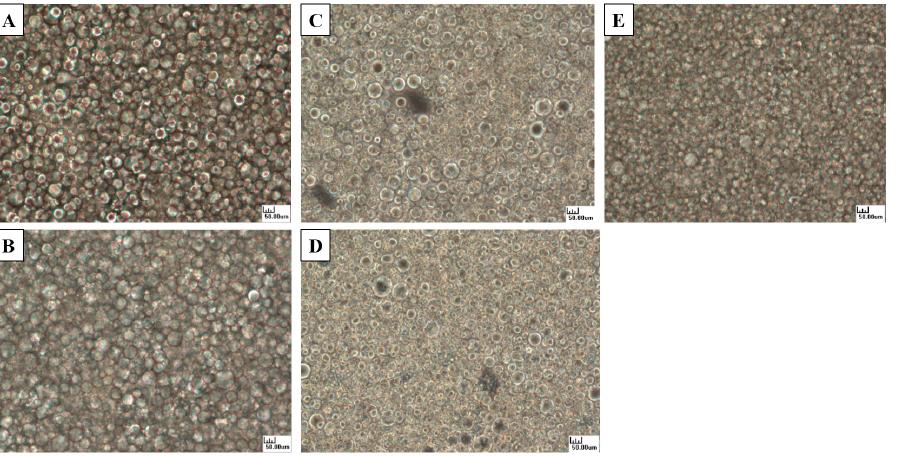
Figure 4. Optical micrographs of the mayonnaise samples. ( A ) Soybean oil; ( B ) soybean oil + MCTs; ( C ) olive oil; ( D ) olive oil + MCTs; ( E ) MCTs.